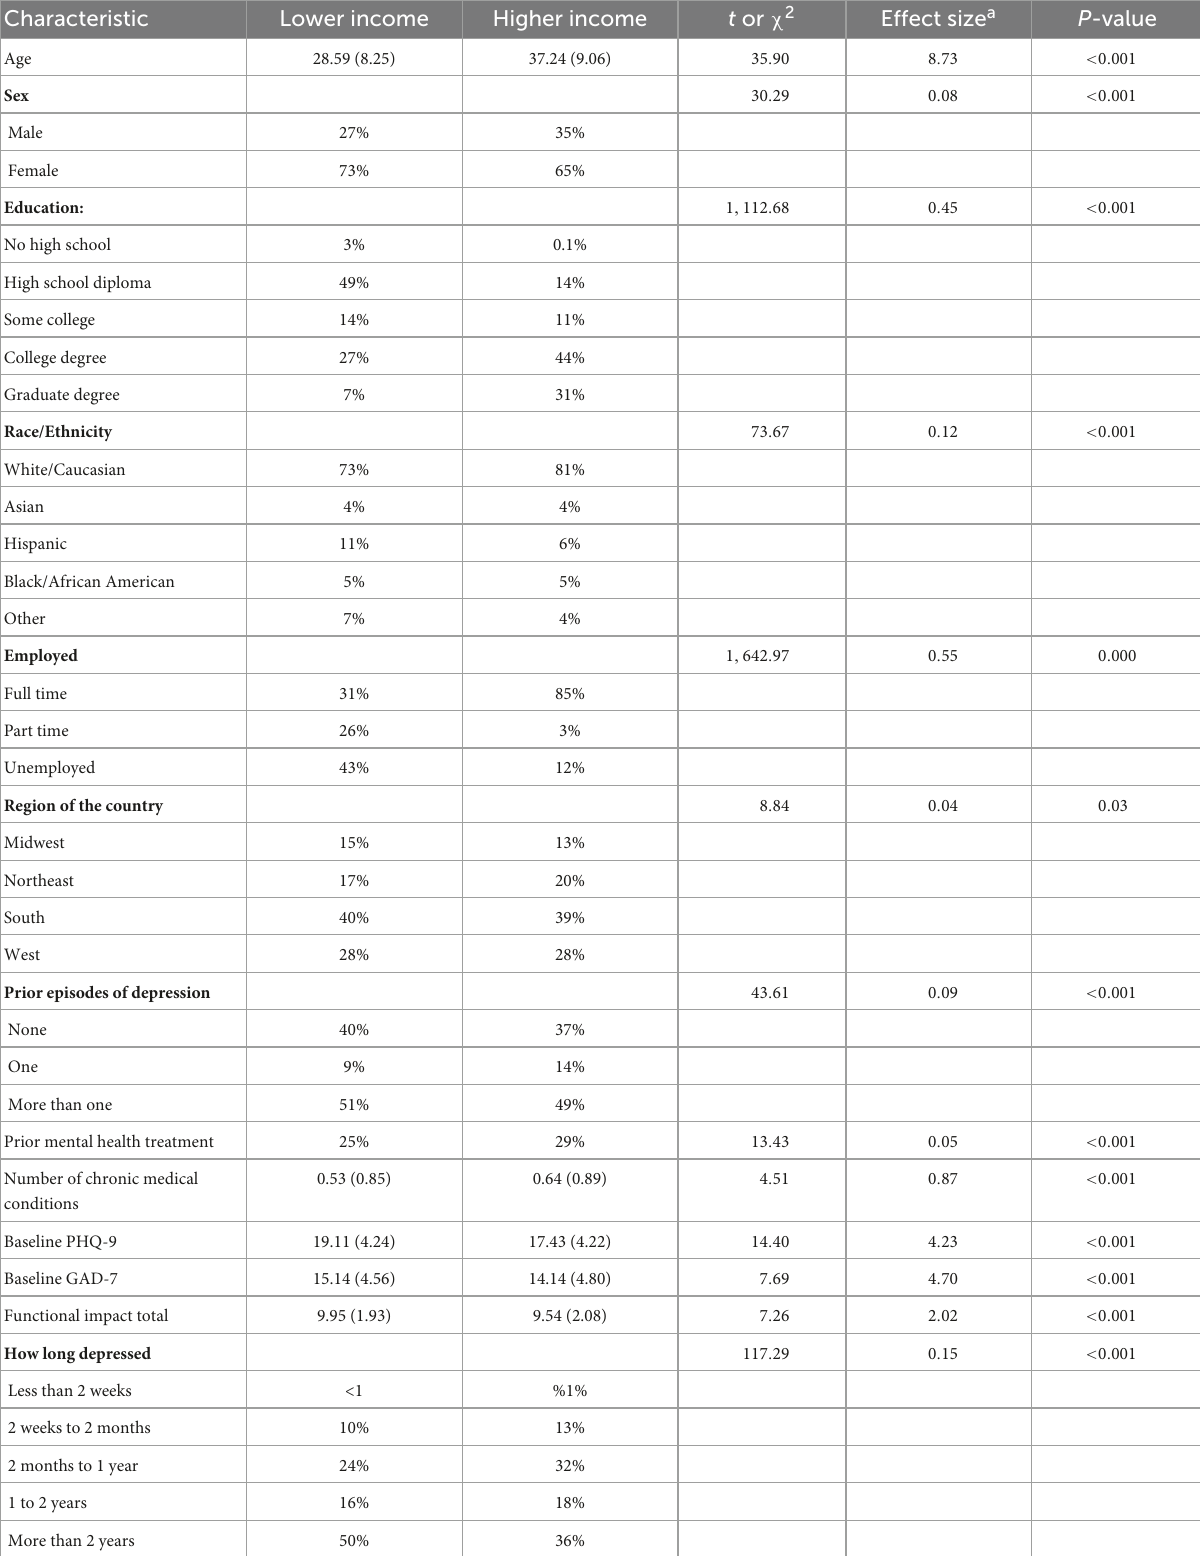
TABLE 1 Characteristics of lower and higher, entire sample ( N =